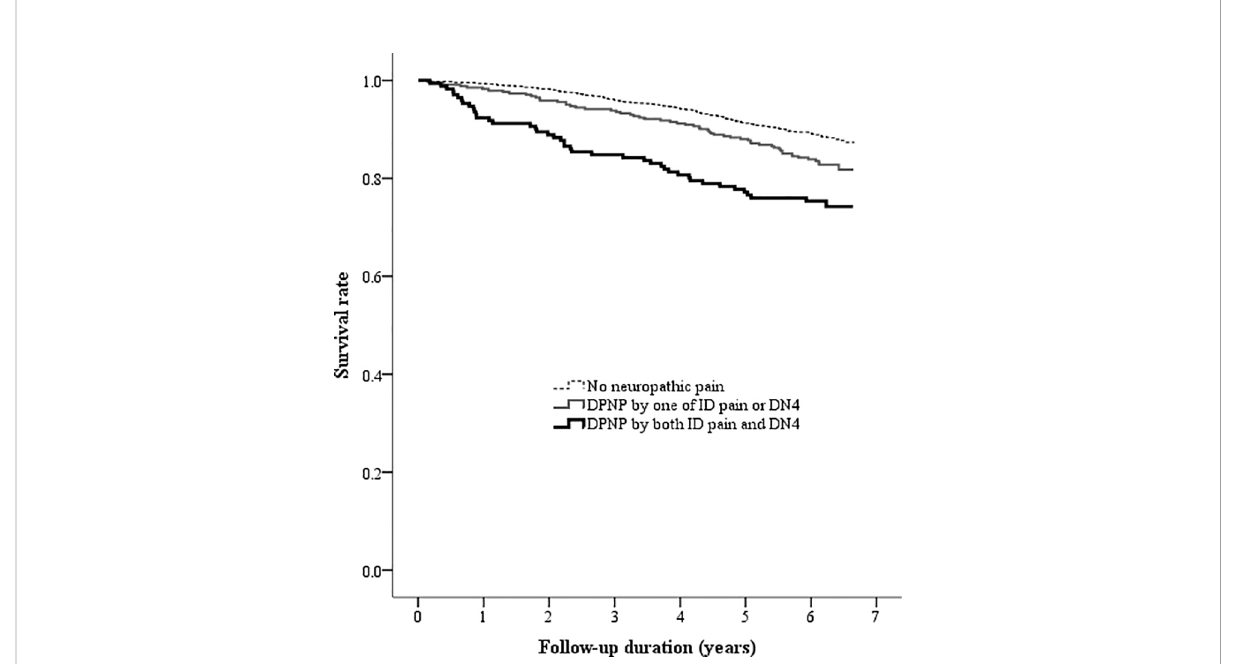
FIGURE 4 Kaplan-Meier curves showing the survival rate among the three groups categorized by the DPNP diagnosis. (DN4, Douleur Neuropathique en 4 questionnaire; DPNP, diabetic peripheral neuropathic pain; ID pain, identi fi cation pain